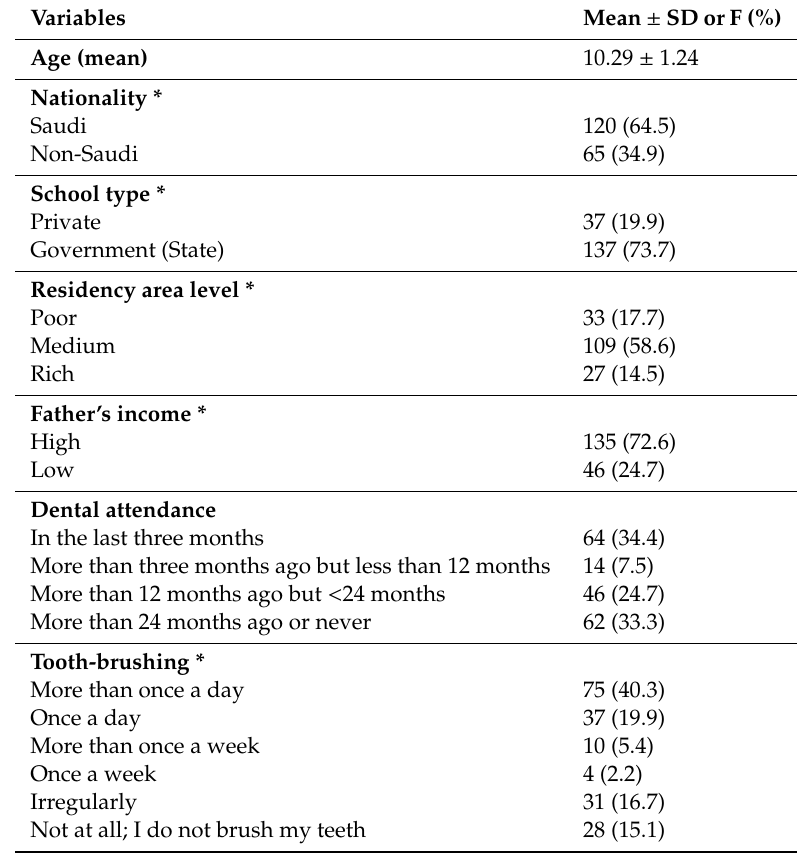
Table 1. Socio-demographic and oral health-related behaviors among children in Madinah, Saudi Arabia (SA) ( n =